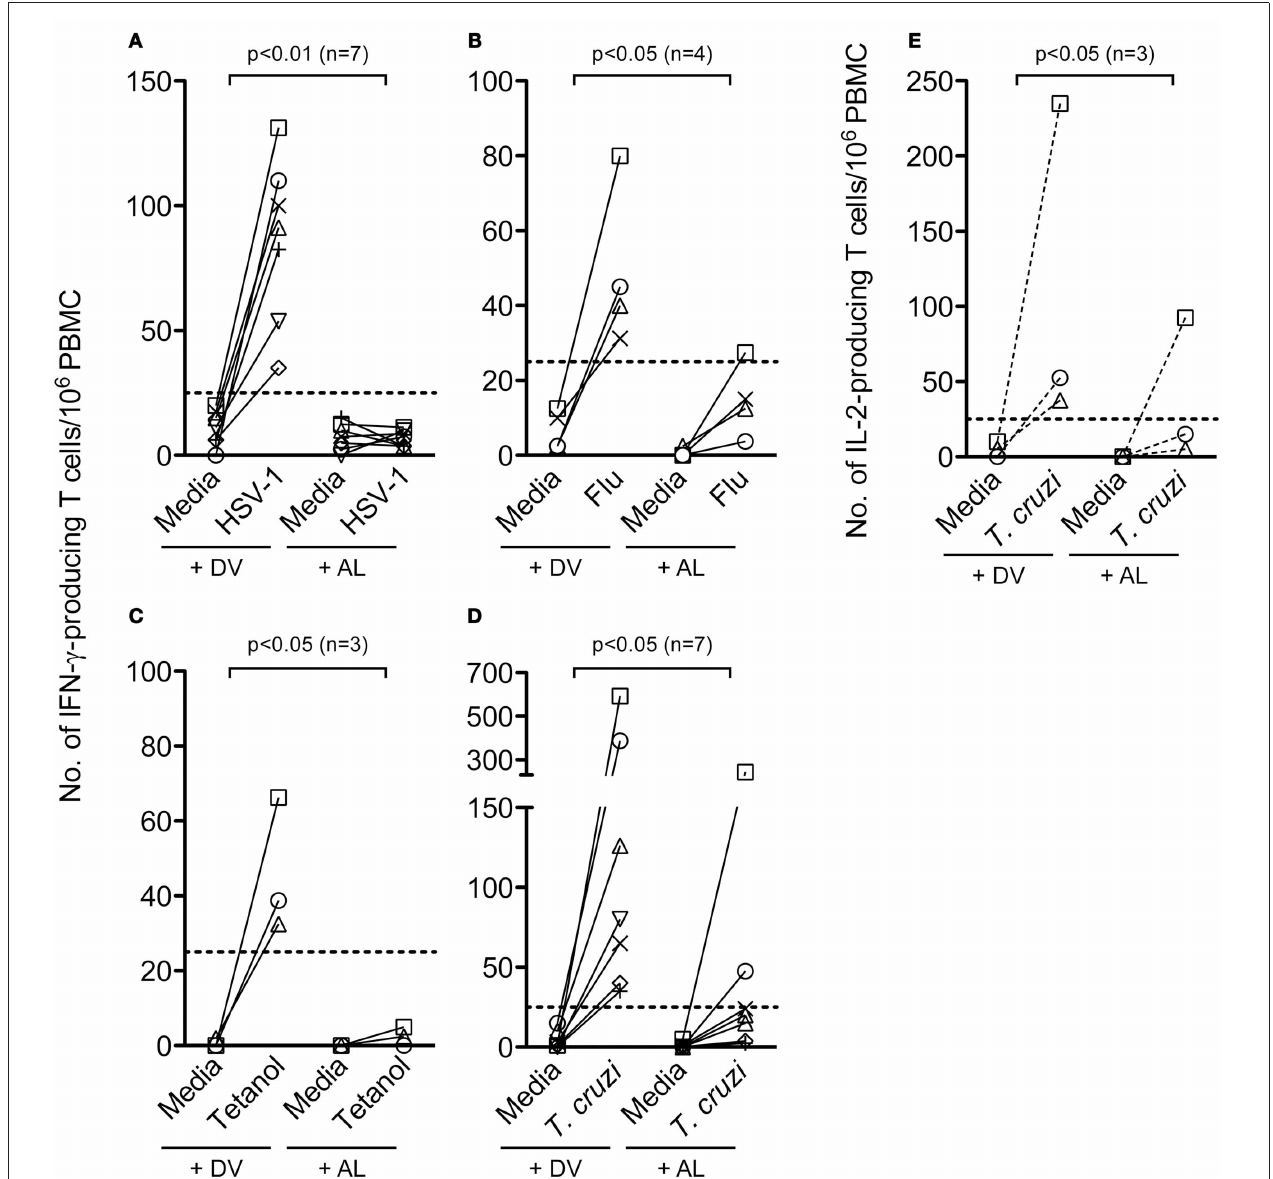
FIGURE 5 | Allopurinolattenuatesantigen-specificactivation-drivenIFN- γ and IL-2 production by human T cells. PBMC from healthy donorswere stimulatedwithfullviralparticlesfromHSV-1 (A) ,aFlu-derivedpeptidepool (B) , tetanus toxoid (C) , or cultured in the absence of antigen stimulation (media),in the presenceof allopurinol( + AL, 300 μ g/ml) or drug vehicle alone ( + DV) for 18–20h, and the numberof IFN- γ -secretingor IL-2-secreting (E) T cells were